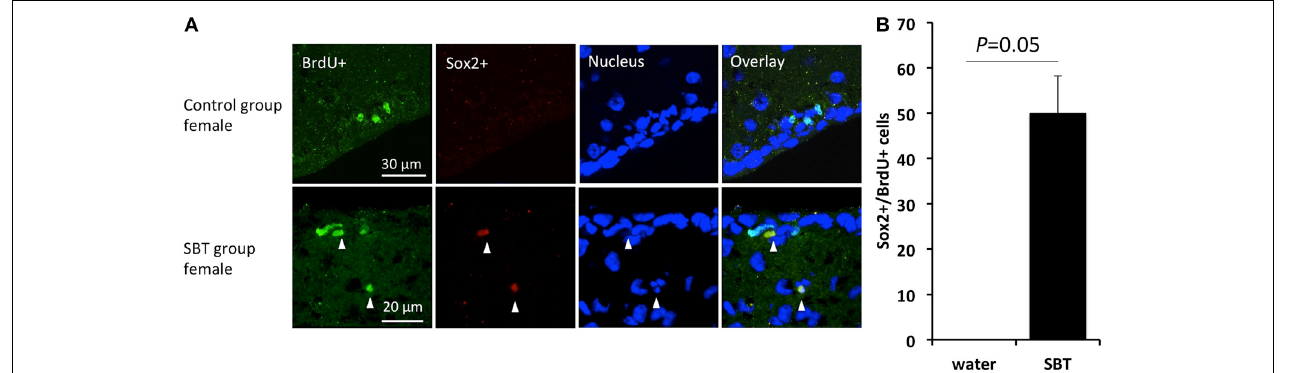
FIGURE 3 | Sox2 expression in the proliferating cells in the SVZ of female mice. (A) Expression of Sox2 in the BrdU labeled cells (arrow heads). (B) BrdU labeled cells included more neuronal progenitors